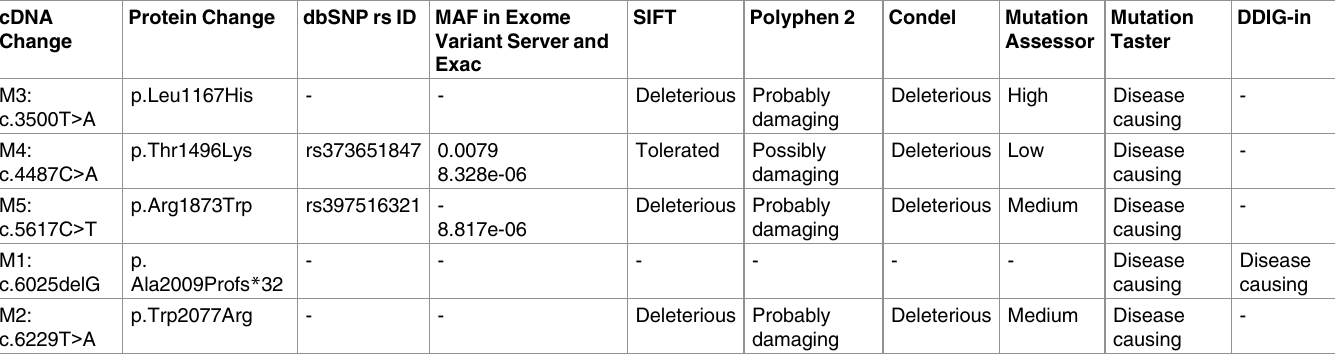
Table 2. Characteristics of MYO7A mutations. cDNA Protein Change Change